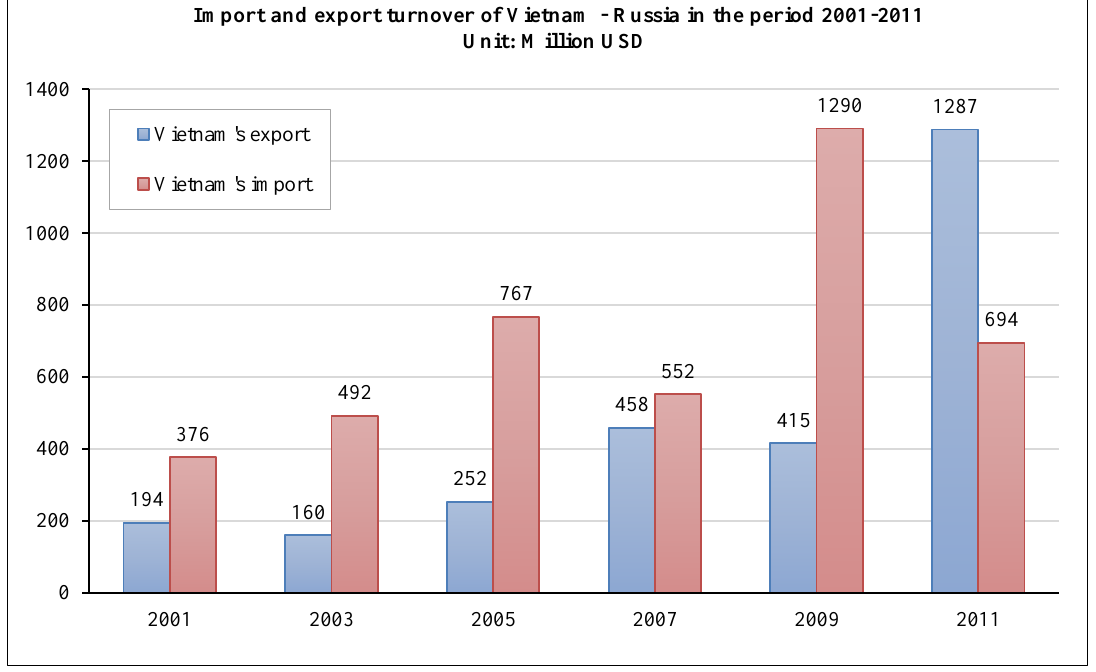
Figure 1. Import and export turnover of Vietnam - Russia in the period 2001-2011 ( Unit: Million